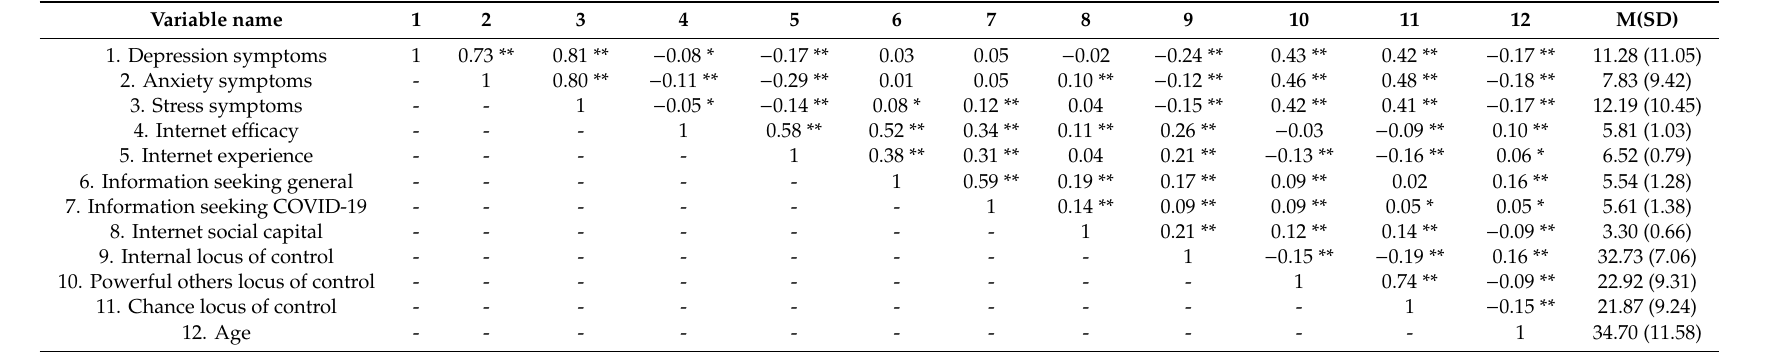
Table 2. Correlation between psychological symptoms, internet variables, locus of control and